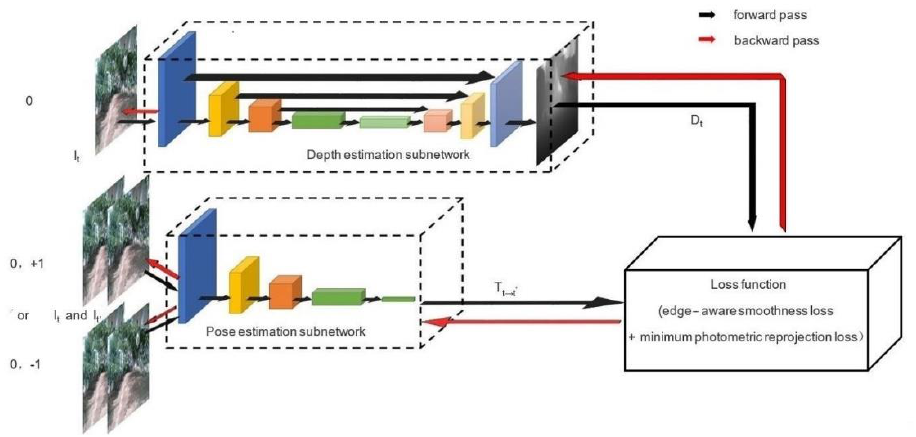
Figure 1 The structure of